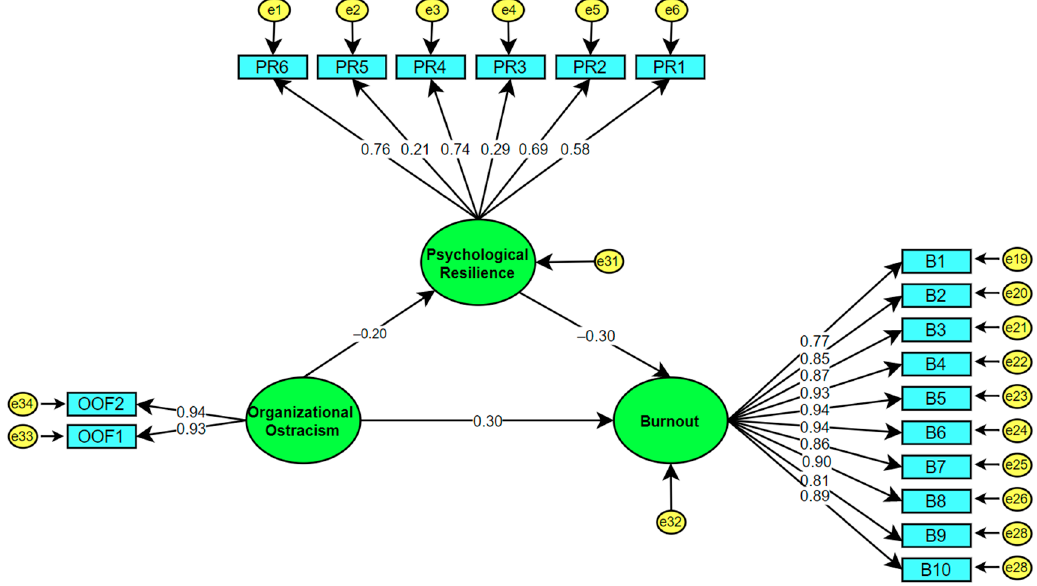
Figure 3. Final hypothesized model. PR = psychological resilience; OO = organizational ostracism; B = burnout; e = error variance.